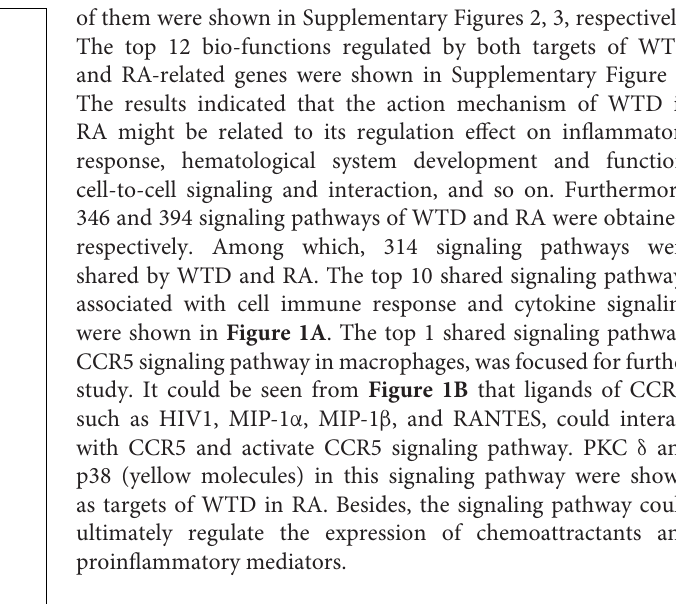
(Supplementary Table 1) and 186 human target proteins (Supplementary Table 2) of WTD were obtained in this